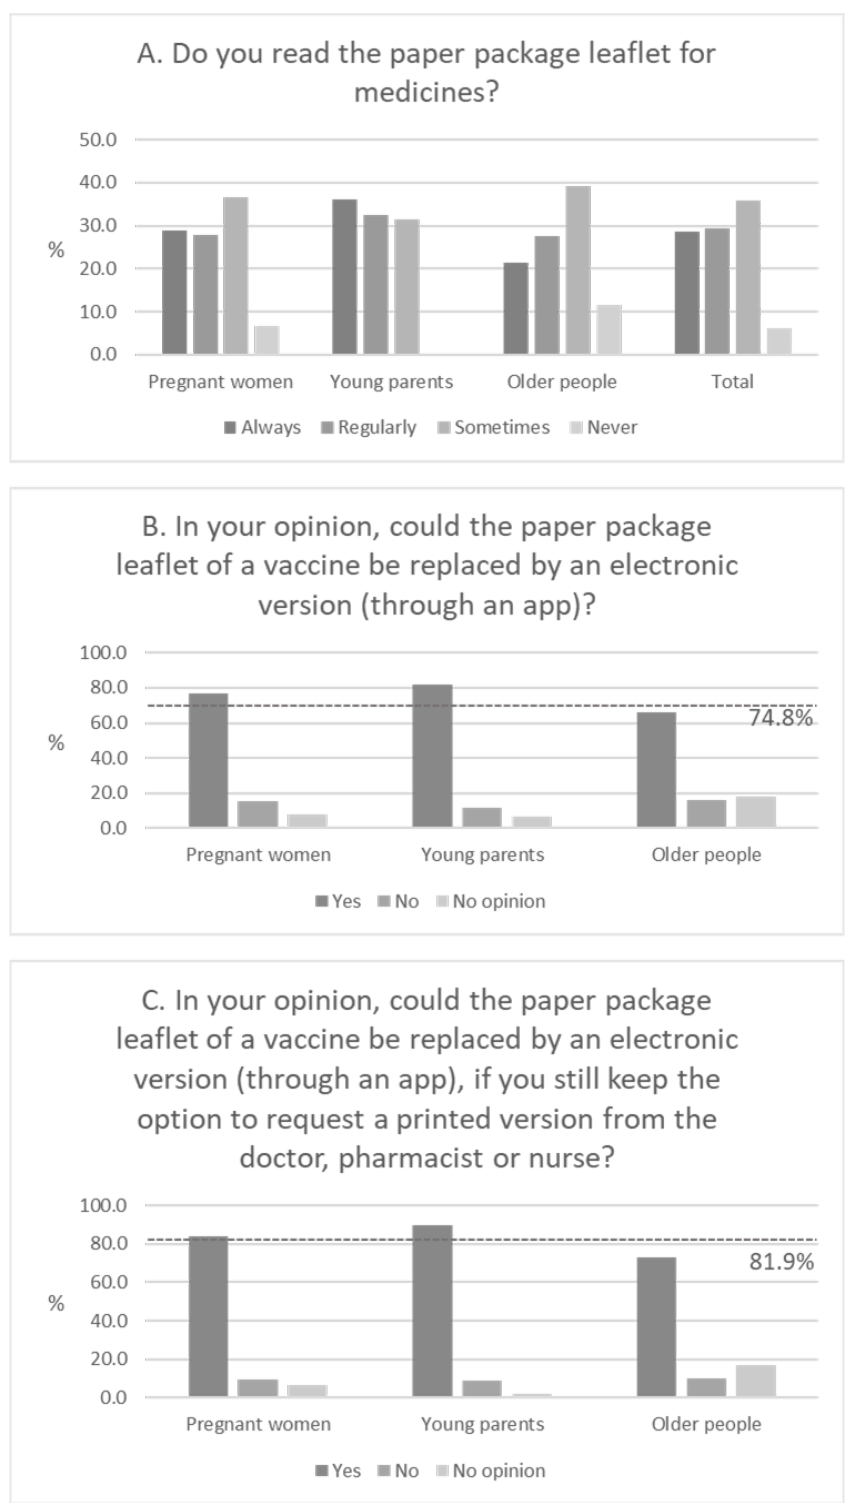
Figure 2. Summary of the main results of the project, with these primary questions: ( A ) Do you read the paper package leaflet for medicines? ( B ) In your opinion, could the paper package leaflet of a vaccine be replaced by an electronic version (available through an app)? ( C ) In your opinion, could the paper package leaflet of a vaccine be replaced by an electronic version (available through an app), if you still have the option to request a printed version from the doctor, pharmacist, or nurse?